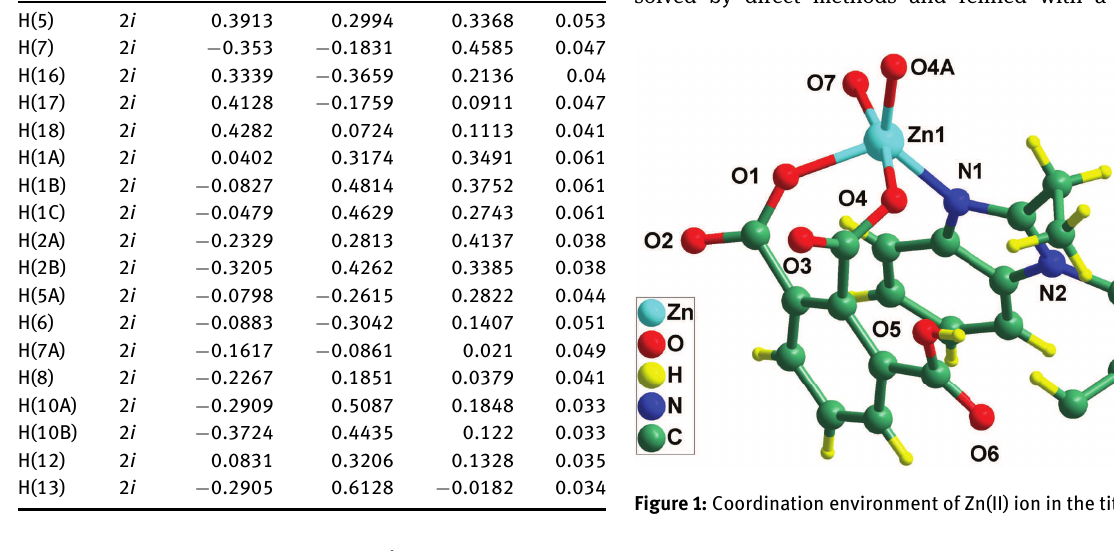
Table 3: Atomic displacement parameters (Å 2 ).